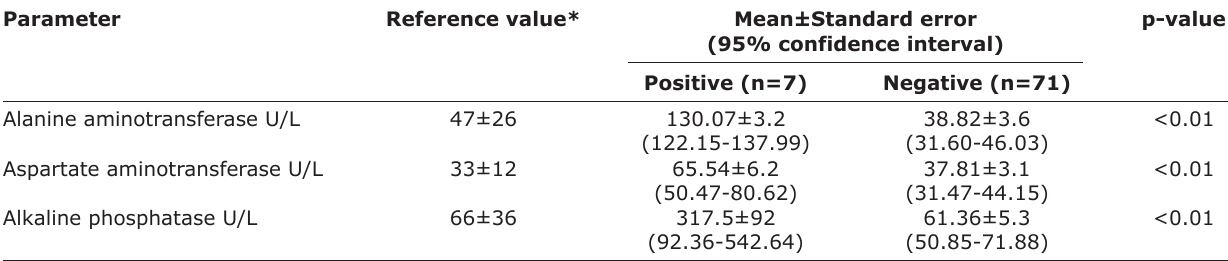
Table-1: Liver function enzymes activity in seropositive dogs for canine hepatitis B virus antigen, compared to those seronegative in Nineveh Province,